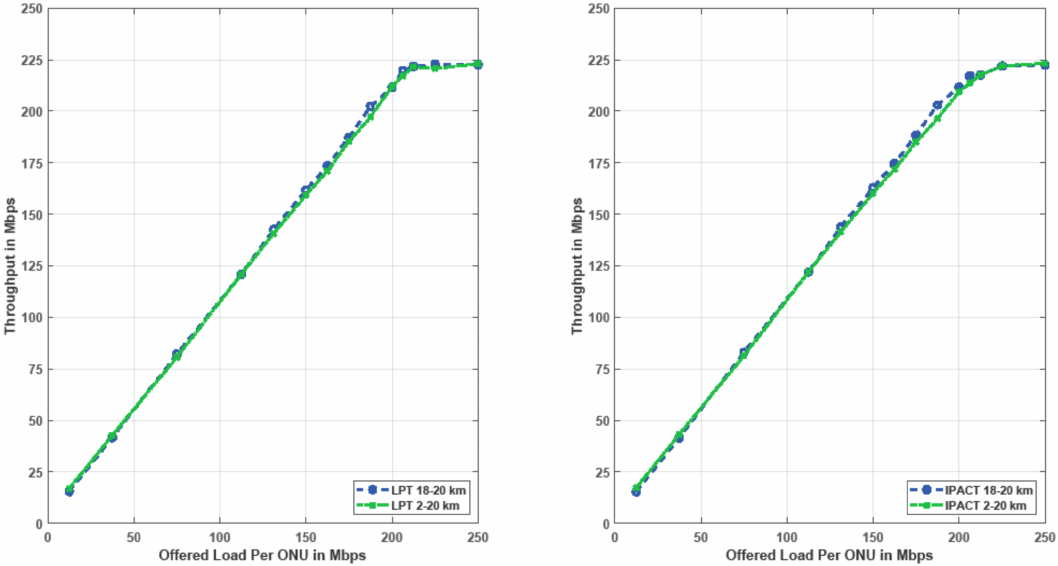
Figure 5. Throughput for all ONUs at LTT = 10 µ s for a range of 18–20 km vs. 2–20 km for LPT ( left ) and for IPACT ( right ).